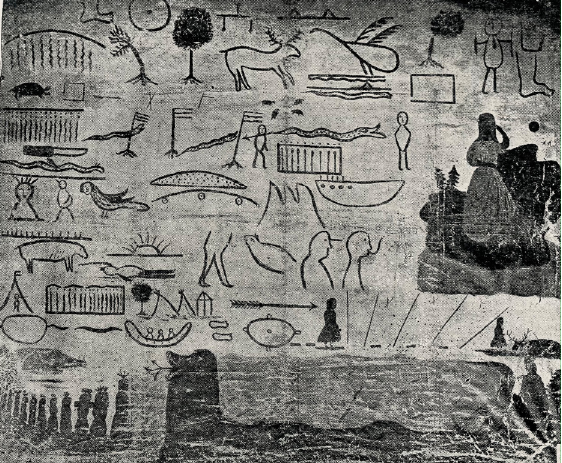
Figure 29. From Mallery (1893, Figure 1289). Fraudulent Ojibwa picture-writing.